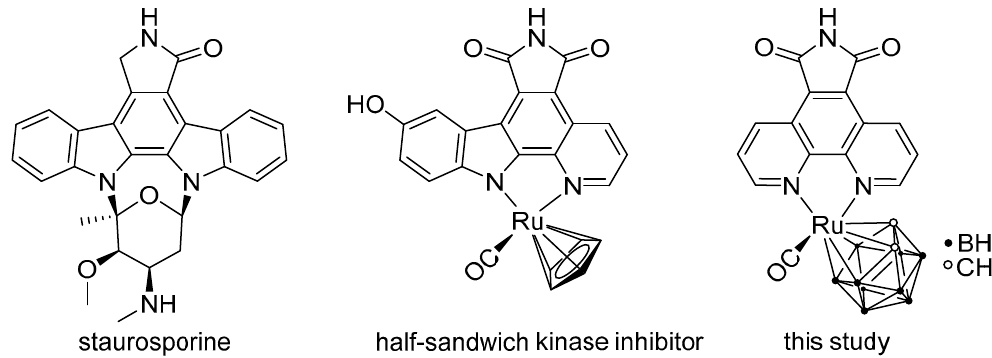
Figure 1. Staurosporine, a ruthenium half-sandwich staurosporine mimic (DW12), and the ruthenacarborane complex synthesized and investigated in this study [17].